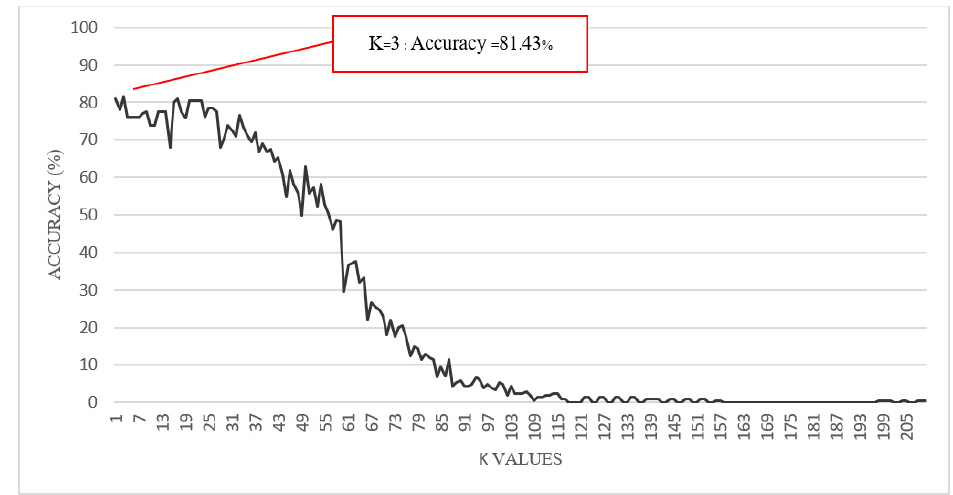
Figure 6. Prediction accuracy of the kNN algorithm with different k values.